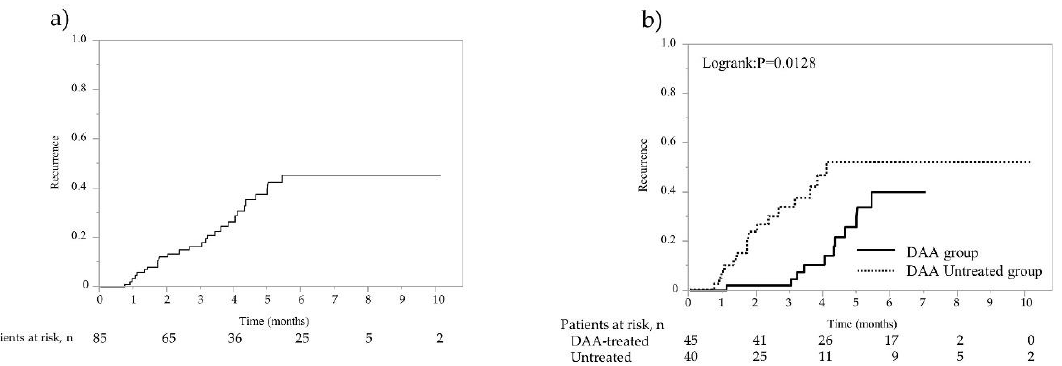
Figure 1. Recurrence rate after propensity score matching (PSM) analysis. ( a ) Overall recurrence rate of patients after curative treatment for HCC. ( b ) Recurrence rates of patients with and without DAA treatment following HCC curative treatment. Solid line represents DAA therapy group; dotted line represents non-DAA-treated group.